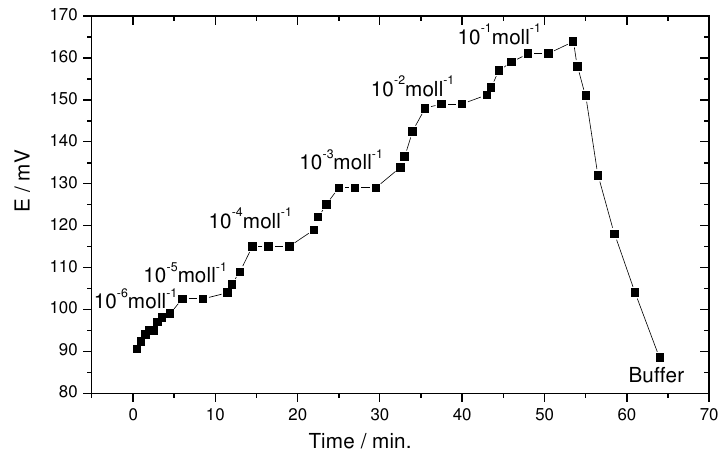
Figure(3) Dynamic response time of the coated graphite rod based